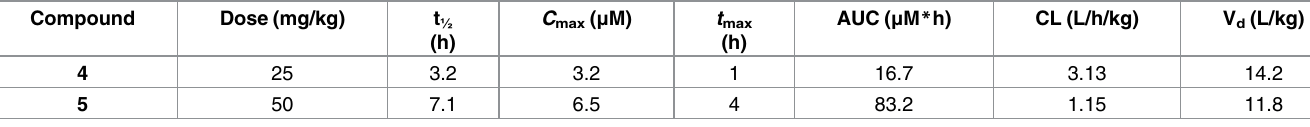
Table 3. Pharmacokinetic parameters for compound 4 and 5 based on oral administration in mice. Compound